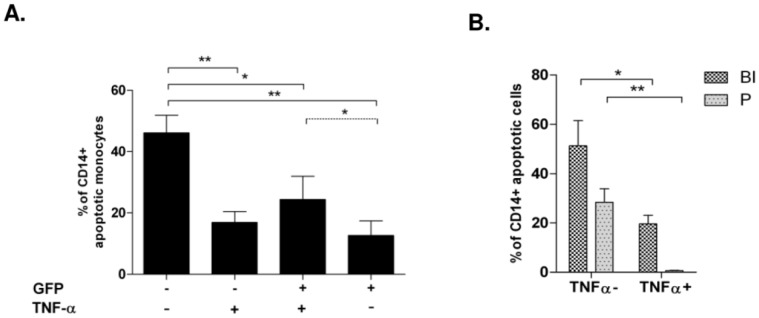
Monocyte apoptosis with regard to bacterial phagocytosis and TNF-α production.Monocytes were infected with E.coli-GFP for four hours and free bacteria were removed. Four hours p.i. hypodiploid DNA content was quantified and analyzed for absence or presence of intracellular viable bacteria (GFP-negative or positive, respectively), and TNF-α content (A; n = 7, * p<0.05, ** p<0.001). Monocytes were infected with E.coli-EOS-FP for one hour and free bacteria were removed. 4 hours p.i. we quantified hypodiploid DNA content in TNF-α -positive and –negative monocytes in the BI- and P-gate (B; n = 5, * p<0.05, ** p<0.001).